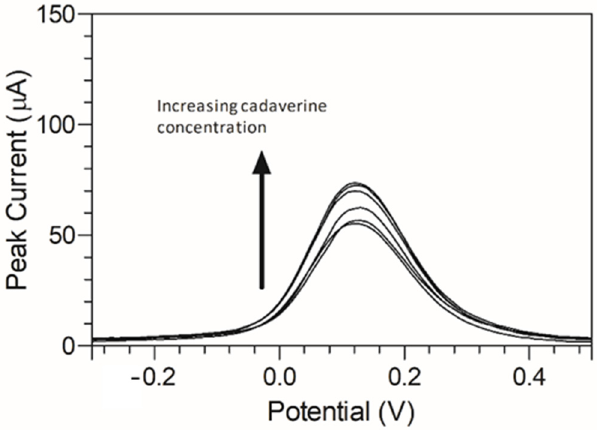
Figure 9. DPV response of cadaverine (30 µg/mL) at C-MWCNT/DAO/EDC-NHS/GA SPE in artifi- cial saliva at a pH of 7.2 vs. Ag/AgCl reference